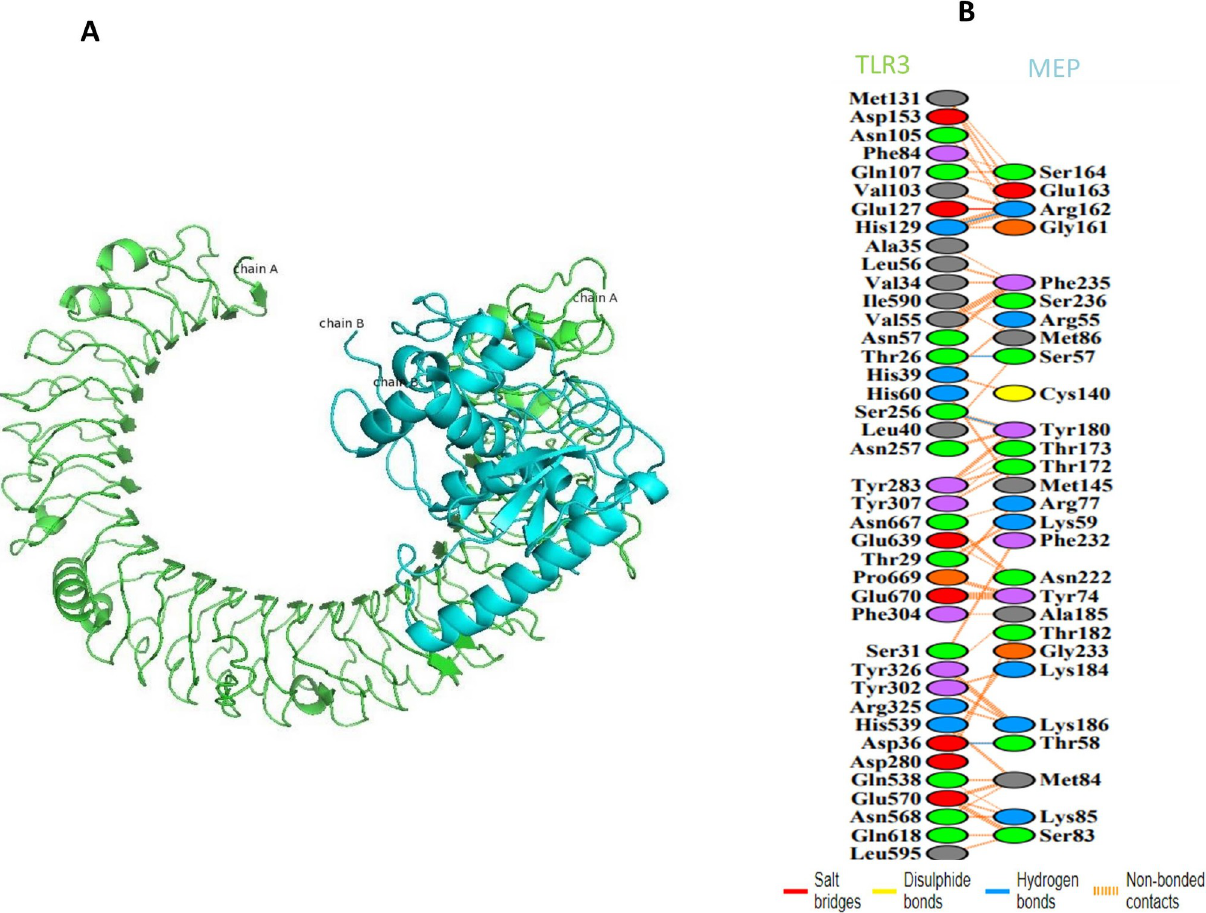
Fig 5. MEP construct docking with human TLR3: (A) MEP-TLR3 docked complex in cartoon representation. MEP vaccine construct is represented with blue colour and TLR3 is shown in green colour. (B) All interacting residues of TLR3 and MEP. 4 Hydrogen bonds with blue lines are indicated. TThe colours of the residues interacting reflect amino acid properties (Negative: Red, Positive: Blue, Neutral: Green, Aromatic: Pink, Pro&Gly: Orange, Cys: Yellow, and Aliphatic: Grey).